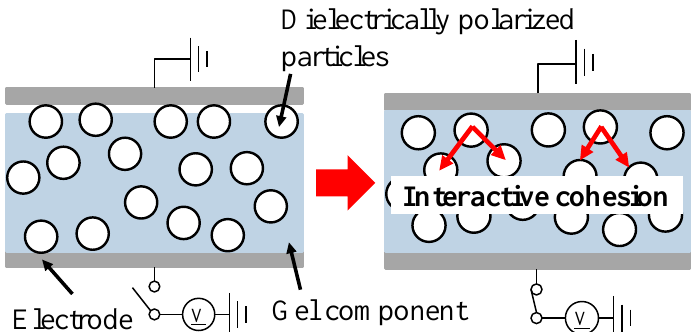
Figure 2. Mechanism of the EA